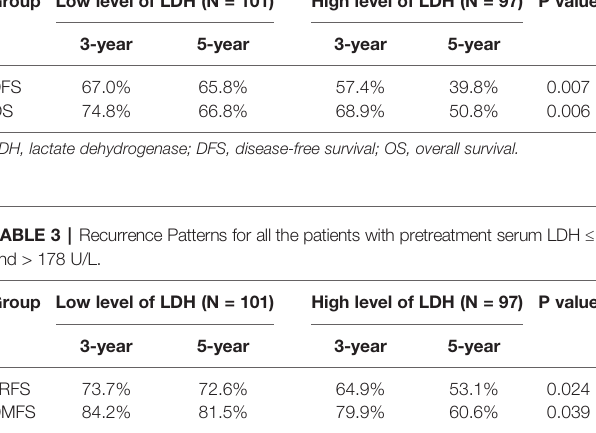
TABLE 2 | Survival analysis for all the patients with pretreatment serum LDH ≤ and > 178 U/L. Group Low level of LDH (N = 101)